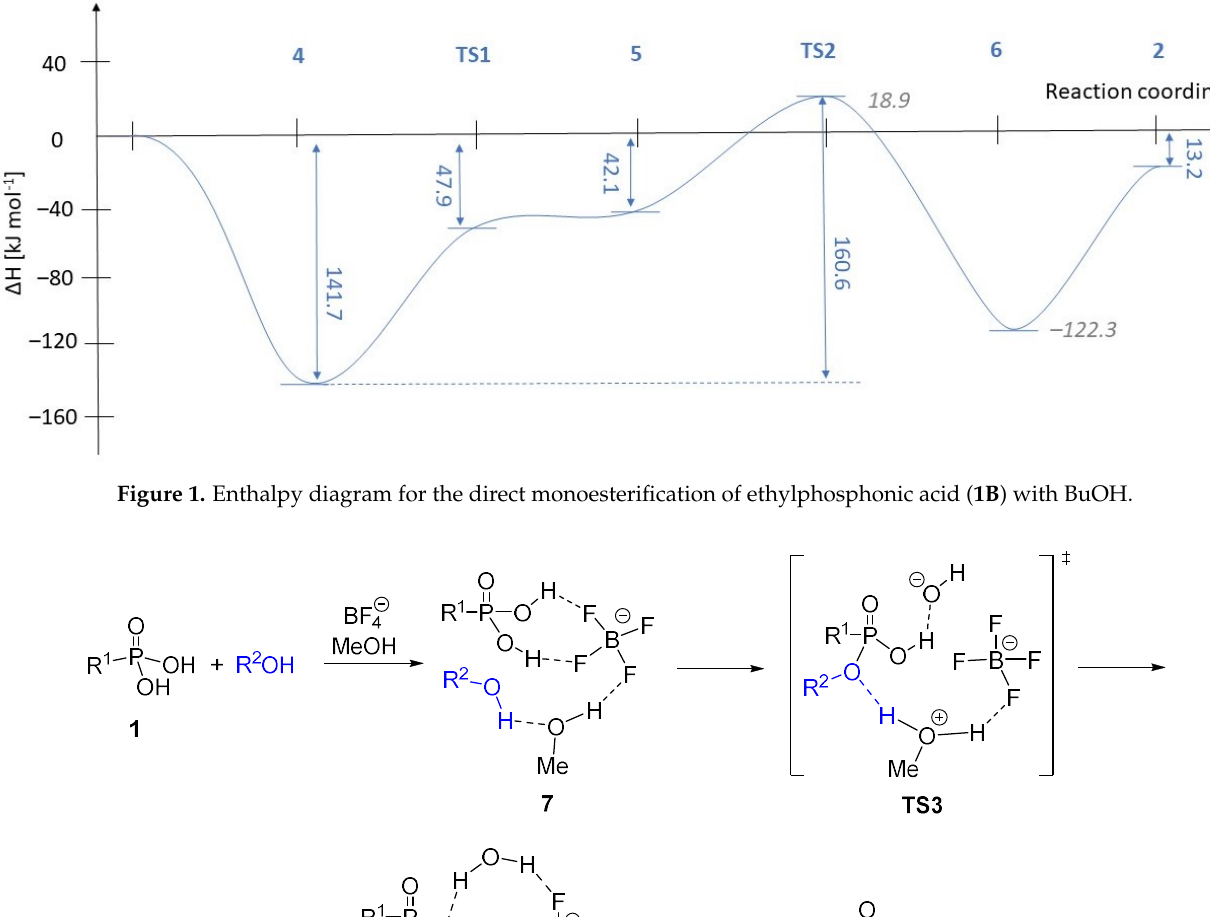
Figure 1. Enthalpy diagram for the direct monoesterification of ethylphosphonic acid ( 1B ) with BuOH.